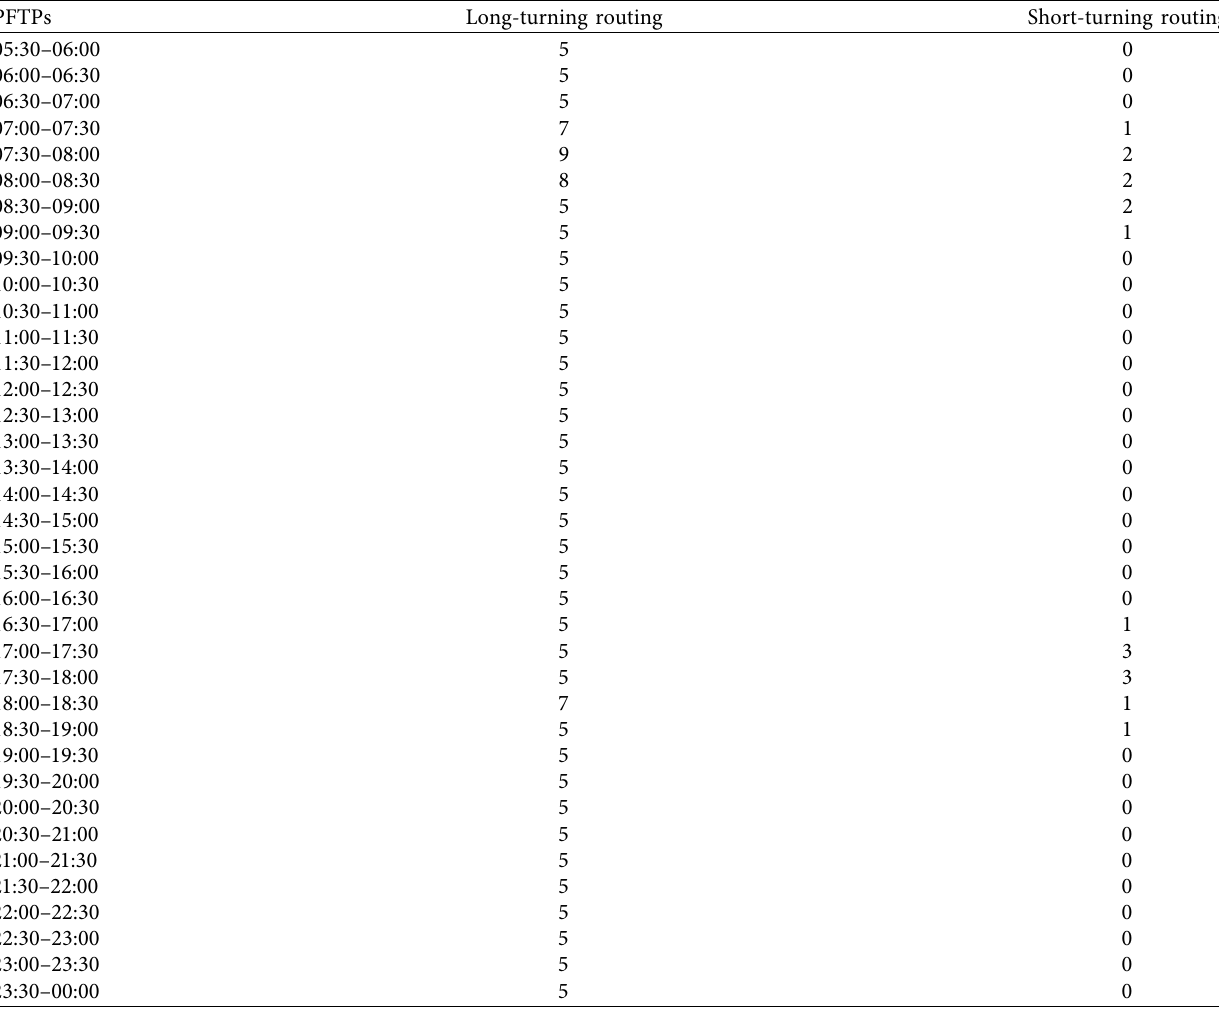
Table 5: Trains of long and short turning routing.